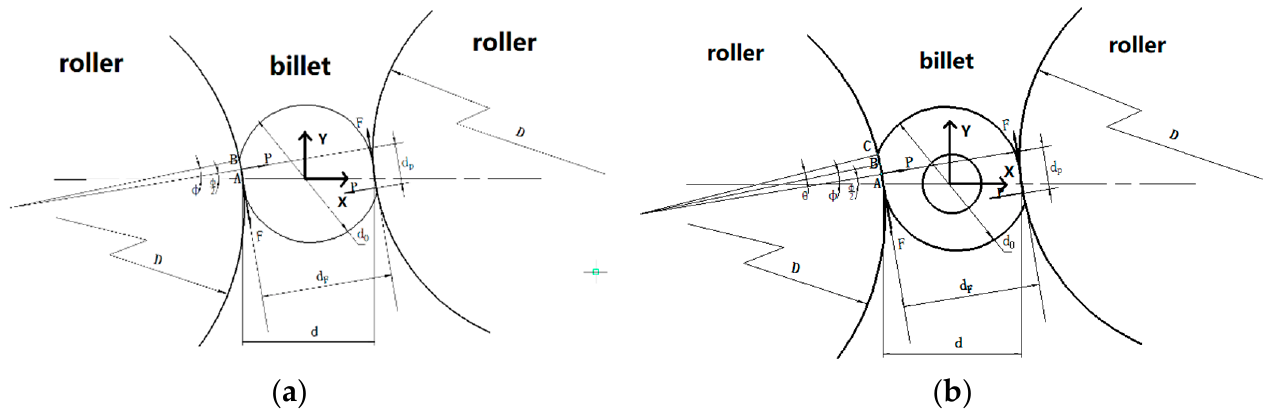
Figure 4. Mechanical model of MSCWR: ( a ) solid shaft; ( b ) hollow shaft [5]. (Reprinted with permission from Ref. [5]. 2023, Springer Nature).